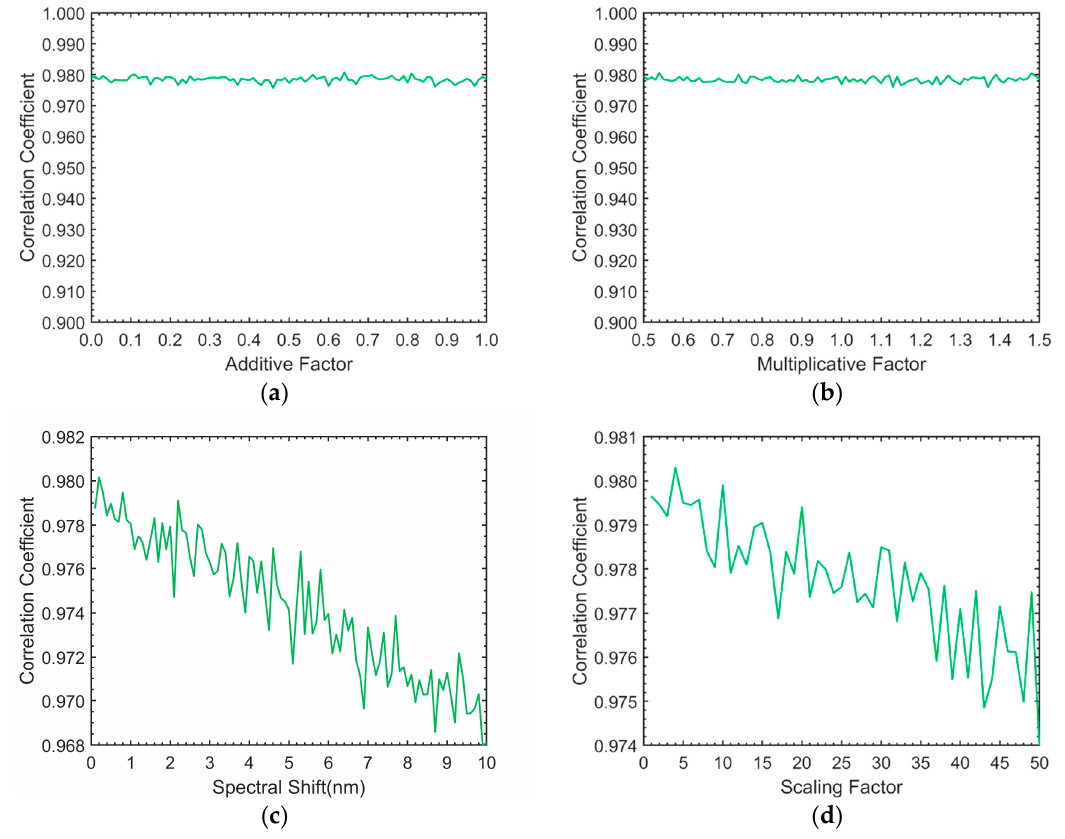
Figure 11. The CC between R AWGN ( λ ) and each of the transformed datasets, R t AWGN ( λ ) . All signals were characterized by an SNR value of 100:1. The trends from Figure 10 persisted, despite being masked by the noise to some degree. ( a ) The CC was invariant to the additive transformation. ( b ) Multiplicative transformations had no impact on the CC. ( c ) The introduction of a spectral shift resulted in a small, but clear decrease in the CC. ( d ) The multiplicative transformation of a single feature was detected in the CC by a gradual reduction.